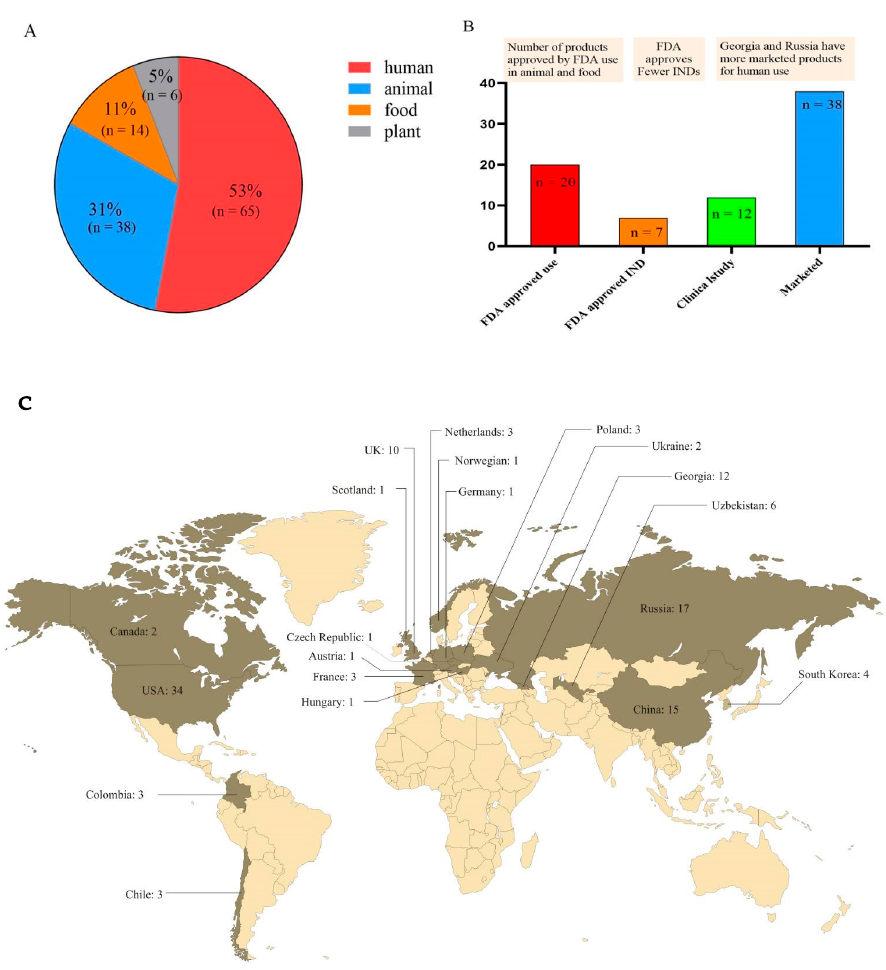
Figure 3. Total phage products are distributed and approved. ( A ) The proportion of phage products in plants, animals, food, and humans. ( B ) The number of phage products that have been approved by the FDA and are in clinical research and marketed for human use. ( C ) Worldwide distribution of the number of phage products.